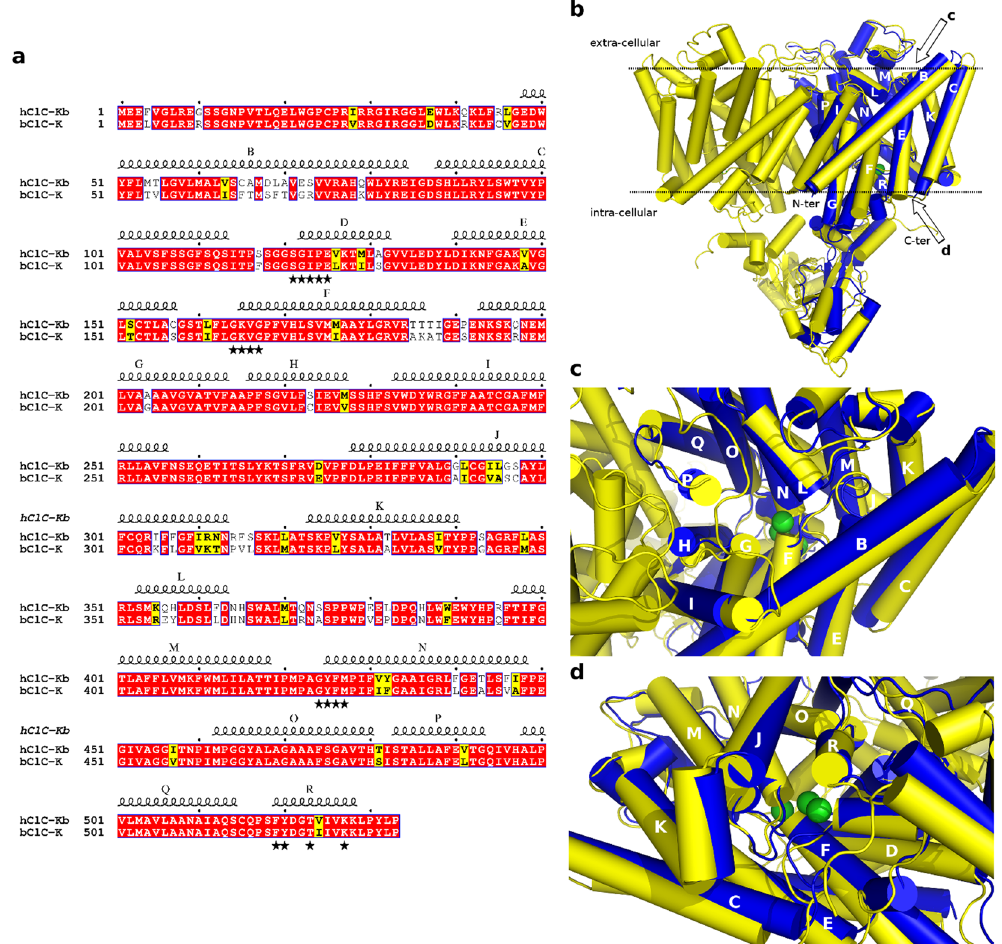
Figure 1. Sequence and structural alignment between the bovine ClC-K (template) and the human ClC-Kb (model). ( a ) Sequence alignment of the human ClC-Kb (hClC-Kb) and the bovine ClC-K (bClC-K) used for the human ClC-Kb model generation. The program ESPript was used to display the alignment 89 . Secondary structures are presented on top of the sequences, conserved residues are boxed and within these regions, residues that are considered similar are highlighted in yellow. ( b – d ) Structural alignment between the known bovine ClC-K channel structure (blue) and the equilibrated model of the human ClC-Kb (yellow). The proteins are depicted in cartoon and the known position for the chloride ions (PDB structures 1OTS and 3ORG) are represented as green spheres. The helices are labelled according to the standard nomenclature. The b panel represents a side view of the channel (the dashed line being the membrane) while the c and the d panels represent respectively an extracellular view and an intracellular